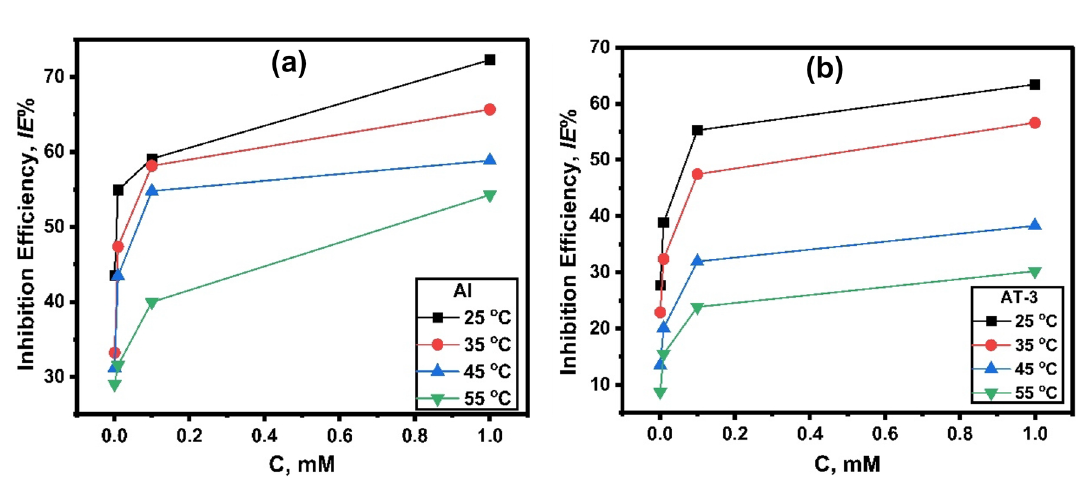
Figure 6. The relationship between the concentration of 2-MBT and the inhibition efficiency ( IE %) for ( a ) Al and ( b ) AT-3 at various temperatures.